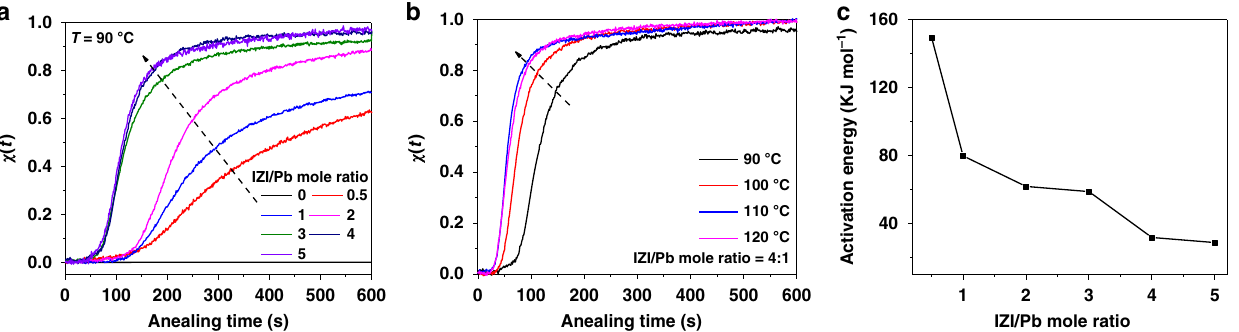
Fig. 3 Kinetic data for isothermally annealed IZI-CsPbI 3 fi lms on ZnO/PEIE substrate. In fl uence of annealing time on the γ -phase transition fraction χ ( t ) for ( a ) the IZI-CsPbI 3 fi lms with different mole ratio (0:1, 0.5:1, 1:1, 2:1, 3:1, 4:1, 5:1) at 90 °C, and for ( b ) IZI-CsPbI 3 with mole ratio of 4:1 at different temperature. χ ( t ) is de fi ned as A ( t ) /A ( t end ), A ( t ) represents the time-dependent absorbance at ∼ 687 nm, A ( t end ) represents the max absorbance. c The dependence of activation energies of the γ -CsPbI 3 fi lms on the IZI content.